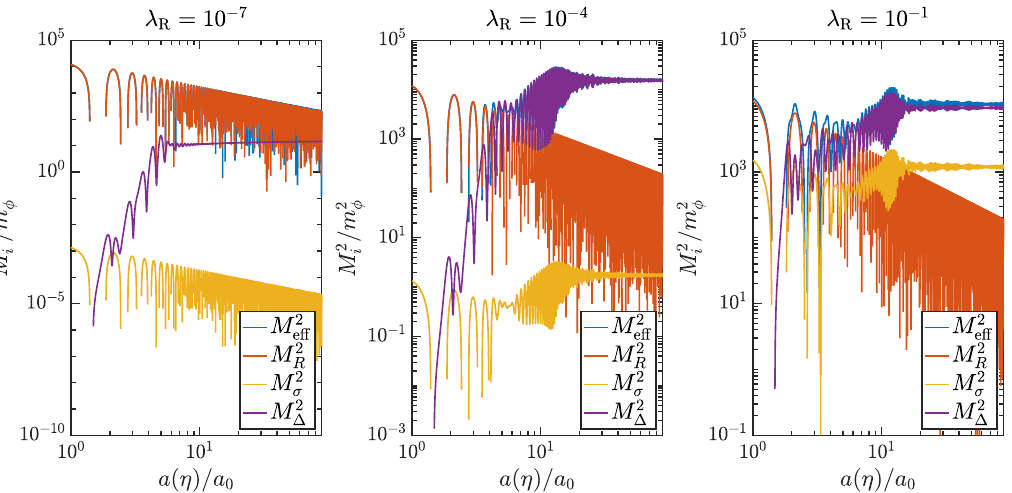
Figure 2 . The effective mass function M 2 (violet) and M 2 (yellow), defined in equations (5.1), for λ R ∈ { 10 − 7 , 10 − 4 , 10 − 1 } , ¯ ξ R = 50 and Γ = 0 σ